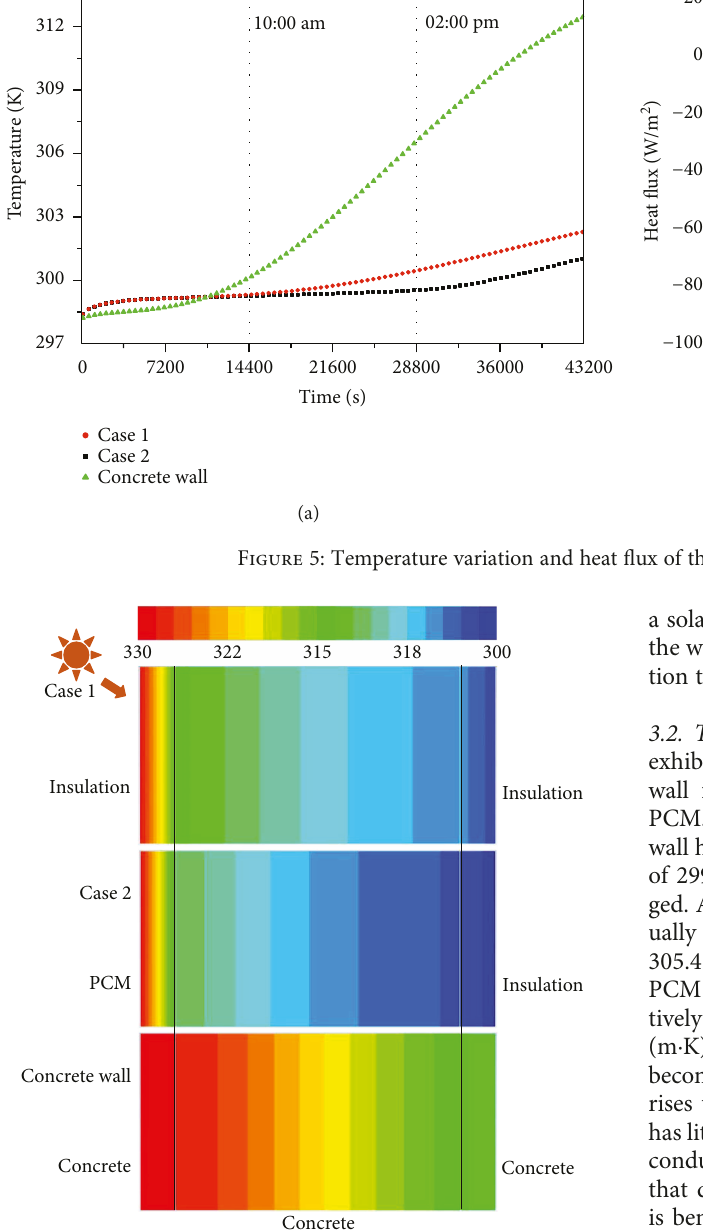
Figure 6: Temperature contour of the wallboard at 06:00pm under di ff erent